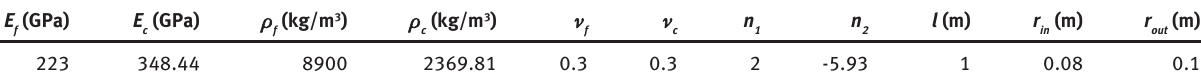
Table 2 Geometric parameters and material properties of the FG